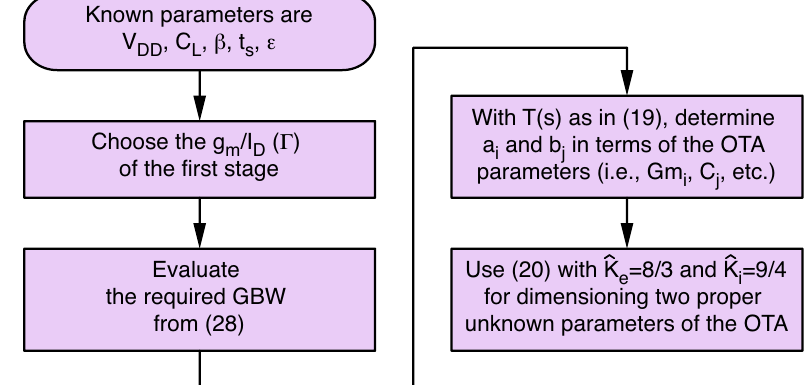
Figure 8. Flow-chart of the proposed design